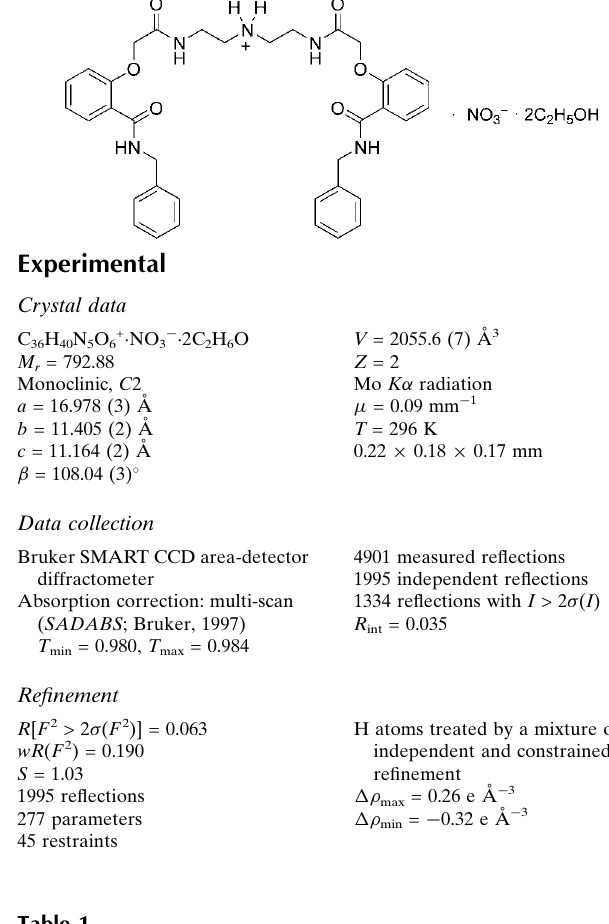
Hydrogen-bond geometry (A˚ , (cid:4) ). D —H (cid:2)(cid:2)(cid:2) A D